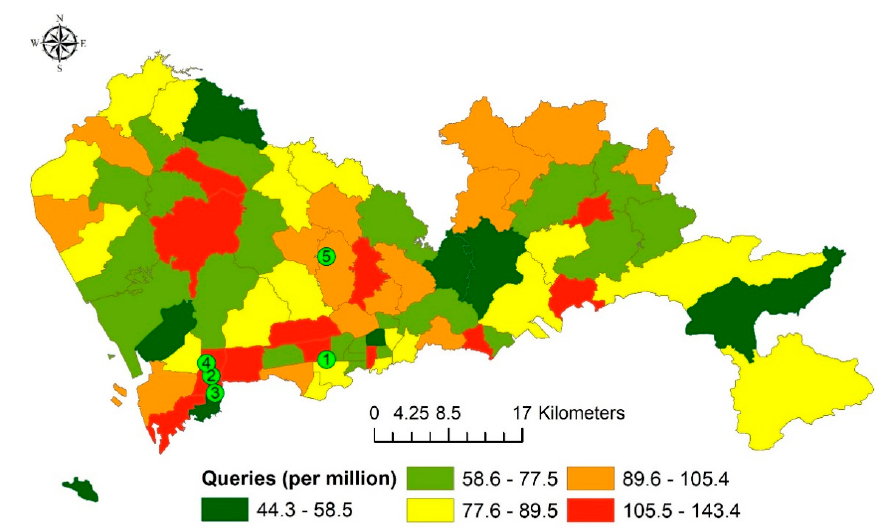
Figure 4. A map showing the sum of standardized search queries in each of the 74 subdistricts. The numbered symbols show the locations of important sites. 1 = Shenzhen Municipal government, 2 = Baidu headquarters, 3 = Ali Center, 4 = Tencent headquarters, and 5 = Huawei headquar-